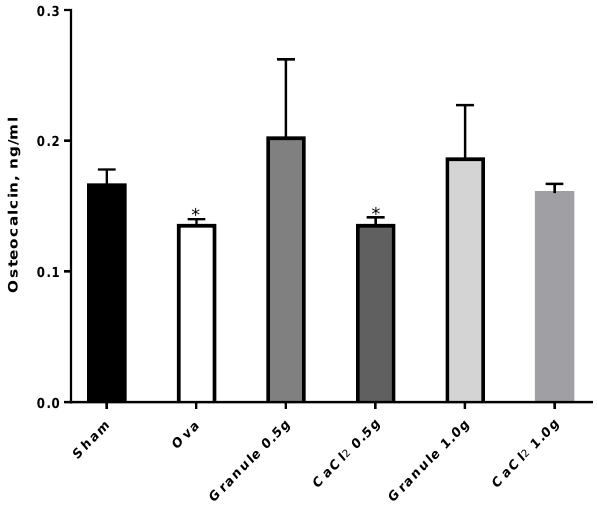
Figure 9. Osteocalcin levels in the di ff erent experimental groups. * p < 0.05 versus